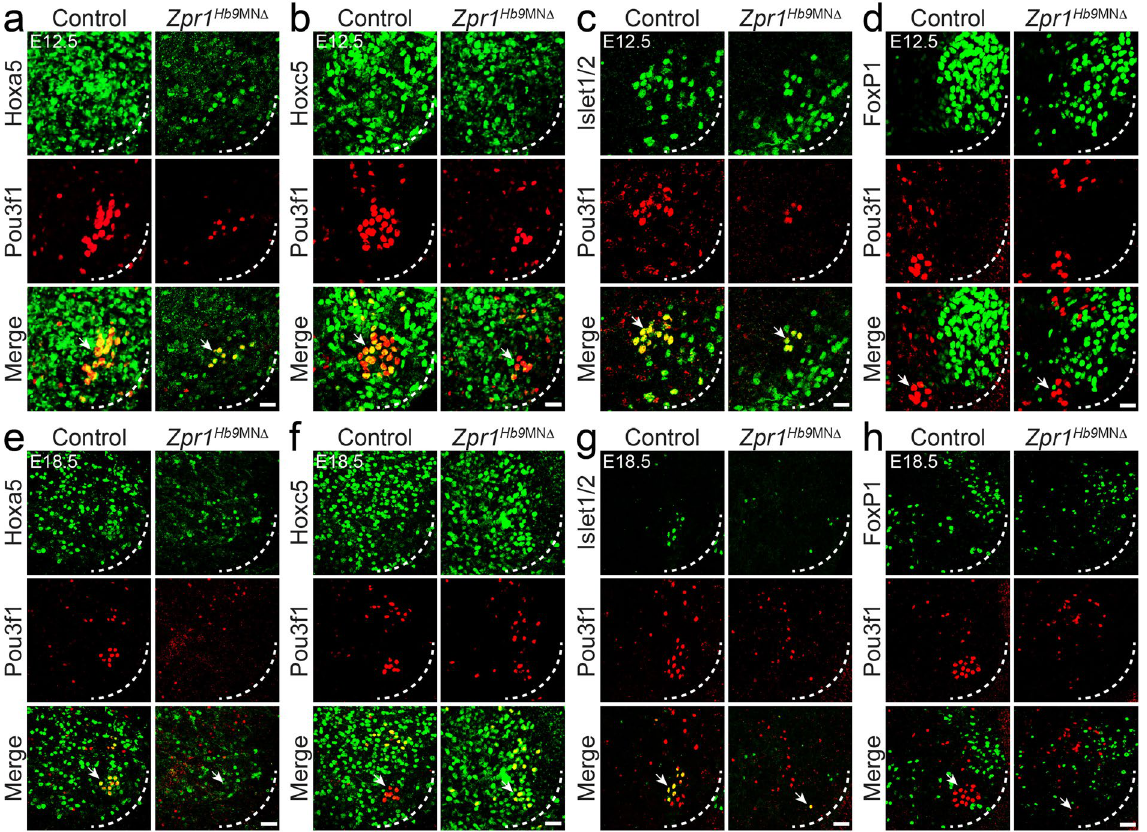
Figure 3. ZPR1 deficiency causes progressive loss of PMC neurons in Zpr1 Hb9 MN Δ mice. Spinal cord sections of the cervical region (C3-C5) from ( a – d ) E12.5 and ( e – h ) E18.5 control and Zpr1 Hb9 MN Δ embryos were stained with antibodies against Pou3f1, Hoxa5, Hoxc5, Islet1/2 and FoxP1 proteins. Immunofluorescence images reveal the effect of Zpr1 mutation on the loss and disorganization of different populations of neurons in the cervical region, including PMC and LMC groups of motor neurons. Quantification of Pou3f1 + , Hoxa5 + , Hoxc5 + , and FoxP1 + neurons at E12.5 and E18.5 stages is presented in Supplementary Figure S3. Neurons were counted in serial sections of C3-C5 region. Neuron losses are presented as (mean ± s.e.m.; n = 3 mice/ group). At E12.5 stage, images ( a – d ) and quantification shows loss (64.29 ± 4.78%, p < 0.0001) of Pou3f1 + motor neurons. By E18.5 stage ( e – h ), Pou3f1 + neurons were barely detectable and quantification shows greater loss (90.00 ± 15.81%, p = 0.0013) of neurons in Zpr1 Hb9 MN Δ embryos. Image analysis and quantification of Hoxa5 + neurons shows non-progressive loss of neurons at E12.5 (64.64 ± 15.54%, p = 0.0032) and at E18.5 (59.35 ± 11.60%, p = 0.0022) stages in Zpr1 Hb9 MN Δ embryos. A smaller loss of Hoxc5 + neurons at E12.5 (31.93 ± 4.80%, p = 0.0002) and E18.5 (24.51 ± 9.81%, p = 0.0369) stages was noted in Zpr1 Hb9 MN Δ mice. A relatively smallest decrease in FoxP1 + LMC neurons at E12.5 (13.59 ± 10.94%, p = 0.2605) that increases to a statistically significant loss at E18.5 (28.17 ± 2.42%, p = 0.0001) was found in Zpr1 Hb9 MN Δ mice. Images ( d , h ) show disorganization and the loss of compactness of FoxP1 + LMC neurons. Dotted arcs represent the orientation of view from the anterior horn side of the spinal cord. Arrows indicate phrenic nerve motor neurons. Scale bars are 25 μ m ( a – d ) and 50 μ m ( e – h